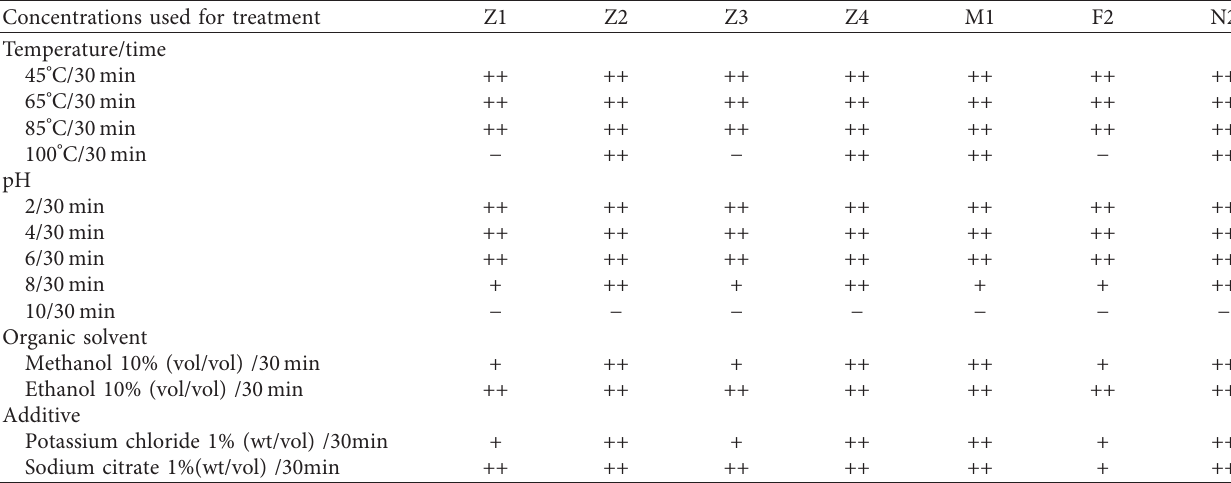
Table 4: Effect of temperature, pH, organic solvents, and additives on the activity of CFS Concentrations used for